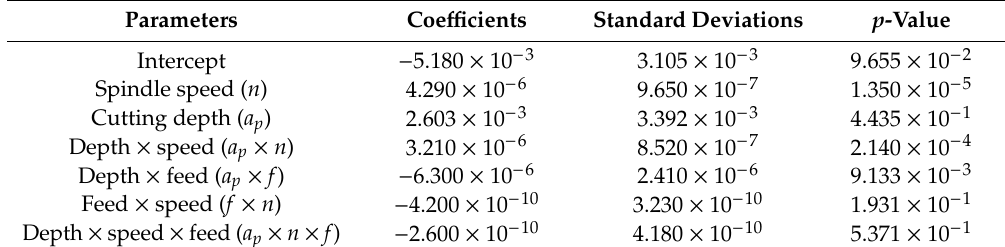
Table 3. Regression parameters of the vibration prediction